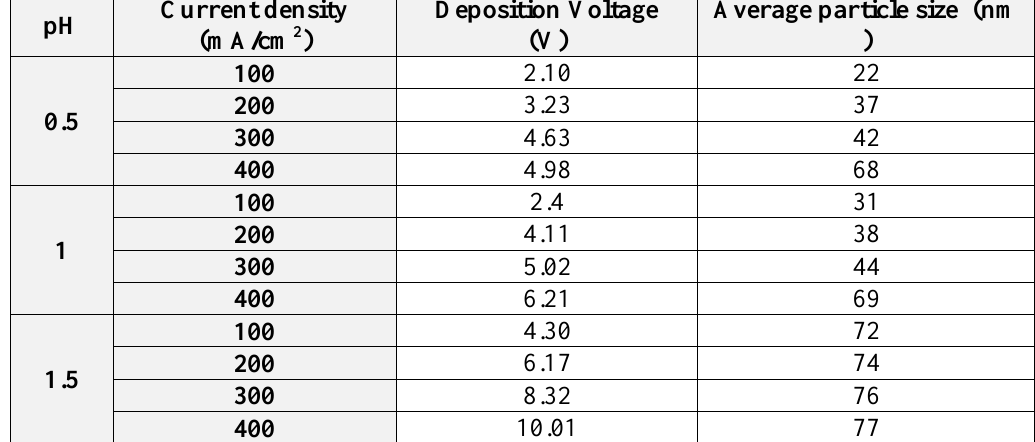
Table 2: Average particle size of the produced CuNPs from CuSO different current density with the required deposition potential.